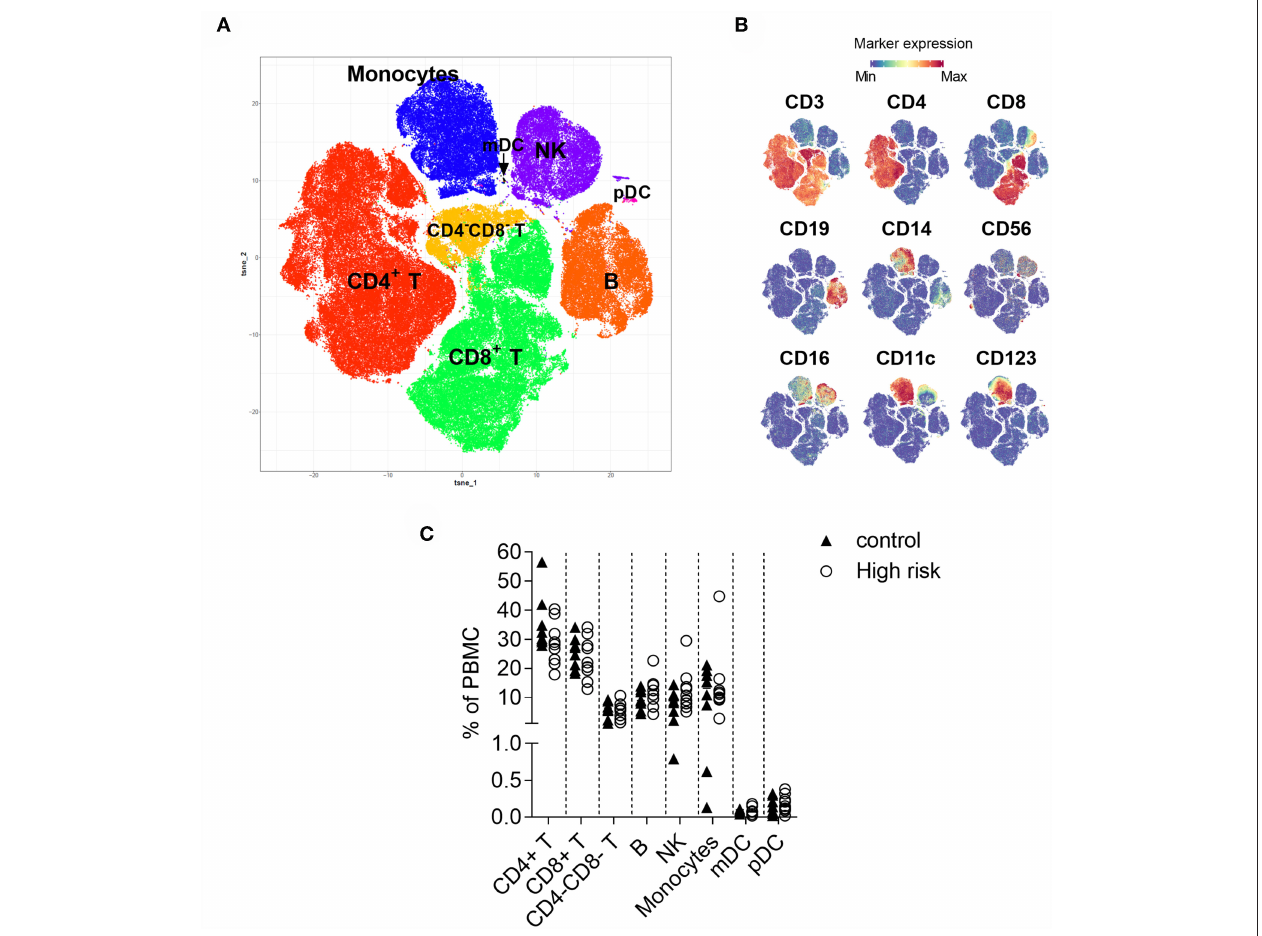
FIGURE 1 | t-Distributed Stochastic Neighbor Embedding (t-SNE) analysis of CD45 + cells. (A) Two-dimensional map where cells (dots) are plotted according to their expression of all markers. (B) Immune cell populations are annotated based on the intensity of expression of lineage antigens. CD4 + (CD3 + CD4 + ), CD8 + (CD3 + CD8 + ), CD4 − CD8 − (CD3 + CD4 − CD8 − ) T cells, B cells (CD19 + ), monocytes (CD14 + ), NK cells (lineage − , CD56 + ), mDC (lineage − CD11c + CD123 − ), pDC (lineage − , CD11c − CD123 + ). The arrow indicates the position of the mDC. (C) Percentage of CD4 + T, CD8 + T, CD4 − CD8 − T, B and NK cells, monocytes, and myeloid and plasmacytoid dendritic cells within peripheral mononuclear cells (PBMC) in individuals with high-risk for type 1 diabetes ( n = 9, white circles) and controls ( n = 9, black triangles). Dots represent individual samples. Differences between groups were tested using Mann-Whitney U-test. No significant differences were